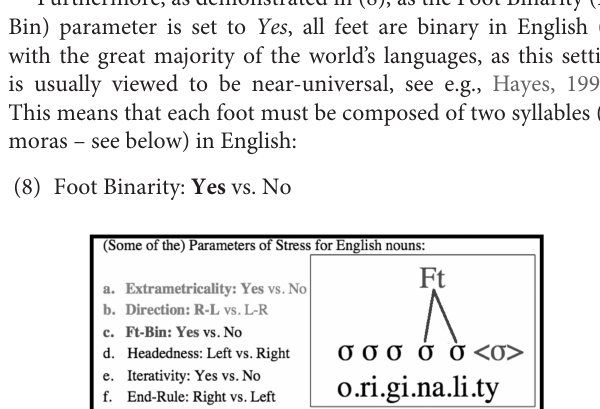
(11) End-Rule: Left vs.